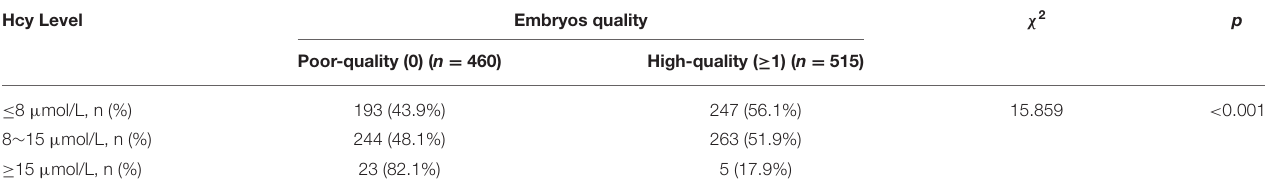
TABLE 2 | Comparison of high-quality embryo rate among different Hcy groups.